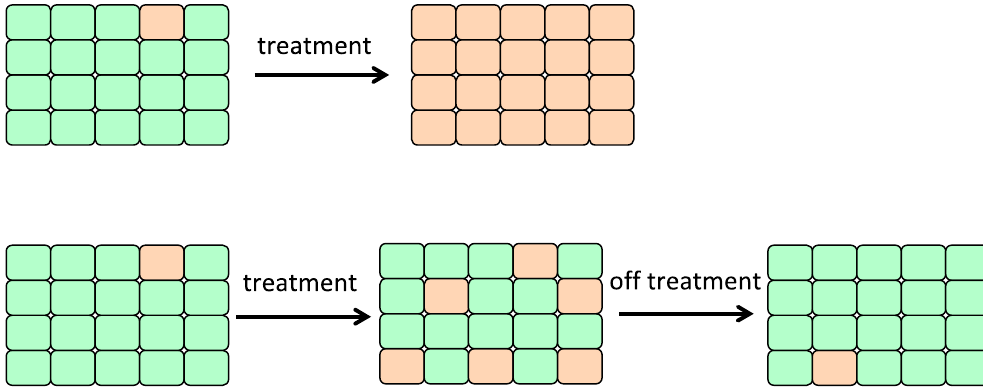
Figure 5. Adaptive therapy. In a maintenance phase of adaptive therapy, drug doses are reduced or chemotherapy is terminated, allowing drug sensitive cells to outcompete resistant subclones. Green cell: drug sensitive cell, orange cell: drug resistant cell.